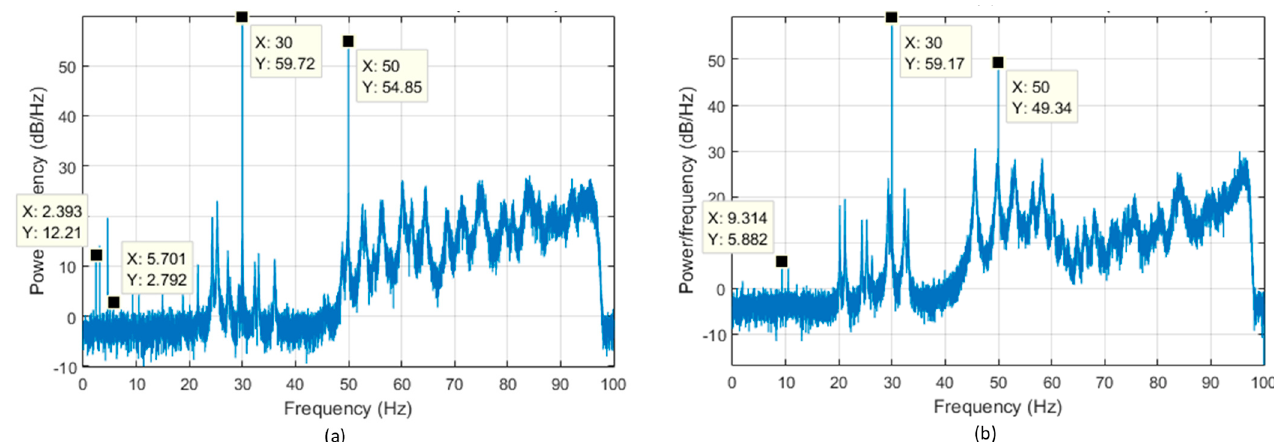
Figure 16. Estimated PSD of Sensor 1 of the noisy data. ( a ) Channel X. ( b ) Channel Z.